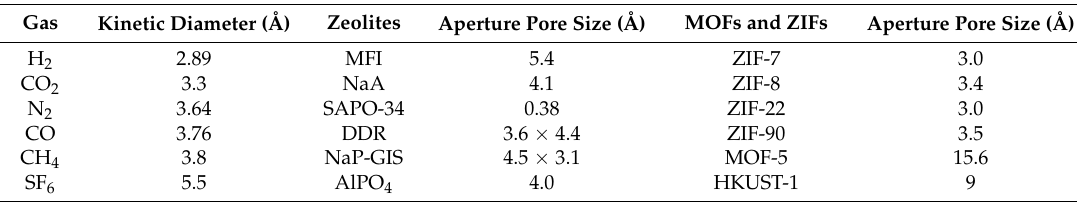
Table 5. Comparison between kinetic diameters of specific gas molecules and the aperture pore size of some zeolite